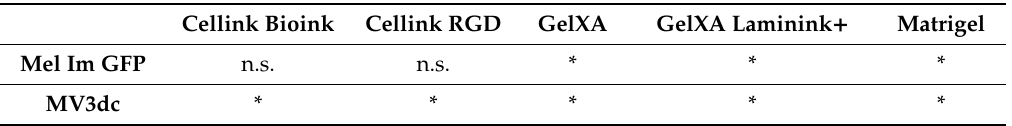
Figure 4. Tumor cell proliferation in bioinks over 14 days of culture. ( A ) Representative fluorescence images showing the proliferation of Mel Im GFP and MV3dc on d4, d7, and d14 after being printed with Cellink Bioink , Cellink RGD , GelXA , GelXA Laminink + and Matrigel. Mel Im GFP and MV3dc showed hardly any growth or proliferation in Cellink Bioink and Cellink RGD but formed irregular clusters in GelXA and GelXA Laminink + . In Matrigel, cells proliferated quickly, Mel Im GFP grew in clusters, which fused together with time, whereas MV3dc cells formed dense chain-like networks throughout the material. Scale bars represent 200 µ m. ( B ) Quantification of proliferation by determination of the mean gray value intensities of at least three fluorescence images per time point plotted logarithmically to emphasize the strongest proliferation of both cell types in Matrigel. The statistical comparison presents the significant di ff erence of mean gray value intensities in Matrigel on day 14 with the other materials on that day. The same significance was observed in comparing day 4 or day 7; however, due to clarity reasons, these significances are not shown in the graph. * p ≤ 0.05 (One-way ANOVA). Table 2. List of statistical significances of cell proliferation comparing day 4 to day 14 after printing in the respective